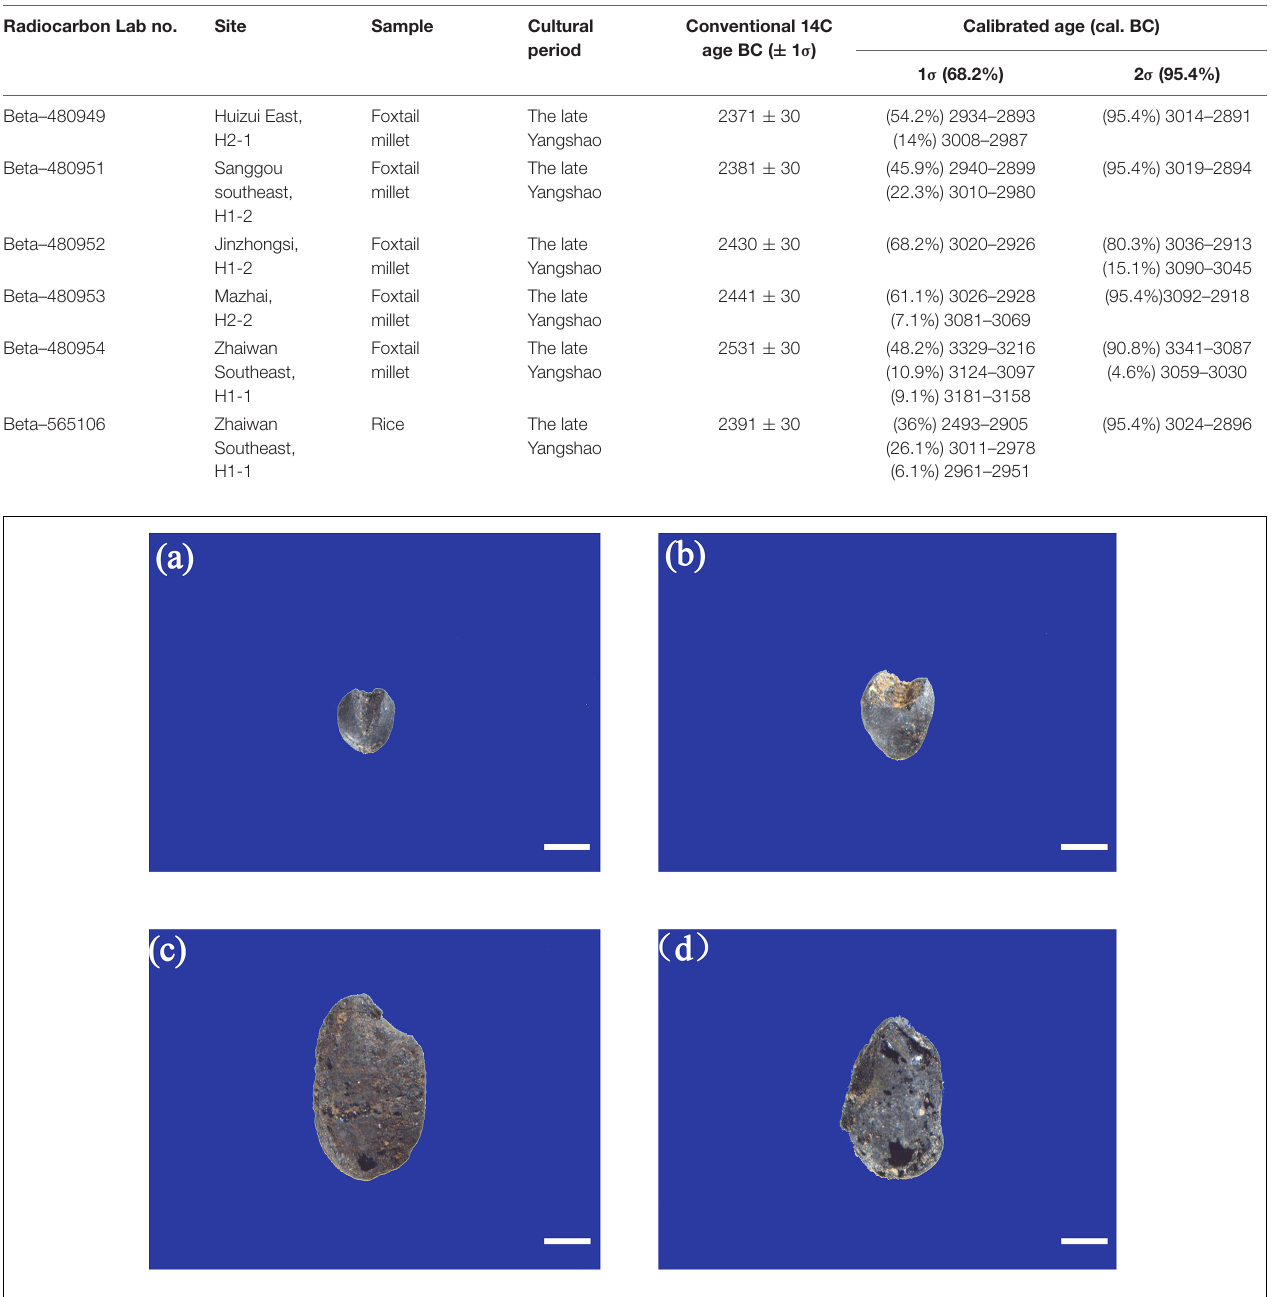
TABLE 1 | Calibrated radiocarbon dates from sites investigated in Luoyang Basin (this study). Radiocarbon Lab no.